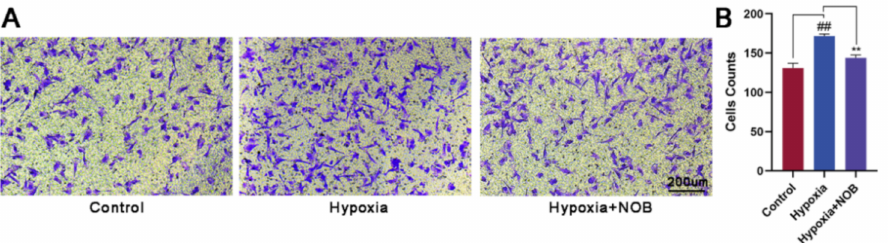
Figure 3. NOB inhibits hypoxia-induced astrocyte migration in Transwell migration assay. ( A ) The images of migrated astrocytes in different groups after 24 h. Scale bar, 200 µ m. ( B ) Statistical analysis of the number of migrated astrocytes. The values are expressed as mean ± SD, n = 3, ## p < 0.01 vs. control, ** p < 0.01 vs. hypoxia